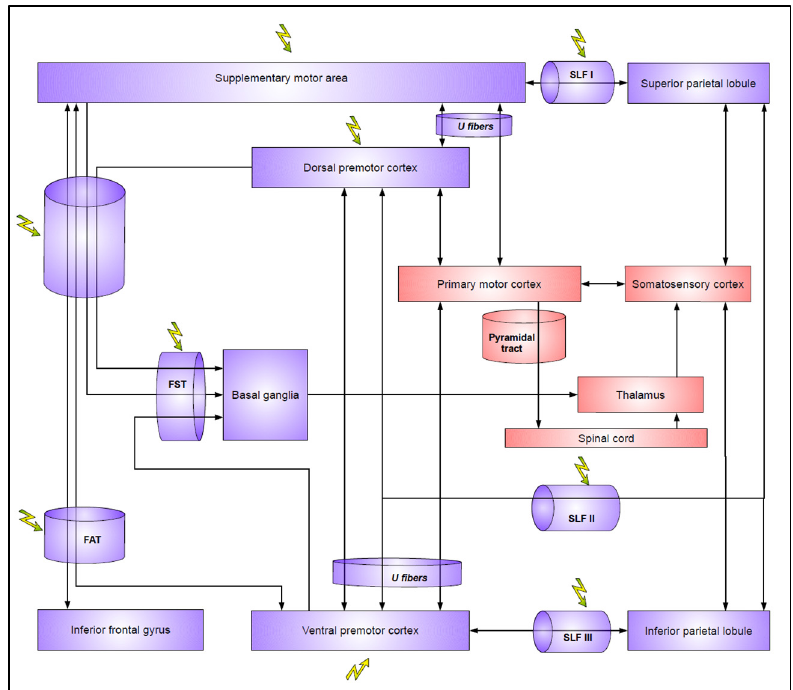
Figure 2. Second level of neural disruption by DES: motor control network. Flashes represent sites eliciting negative motor responses with DES. SLF: superior longitudinal fascicule; FST: fronto-striatal tract; FAT: frontal aslant tract.